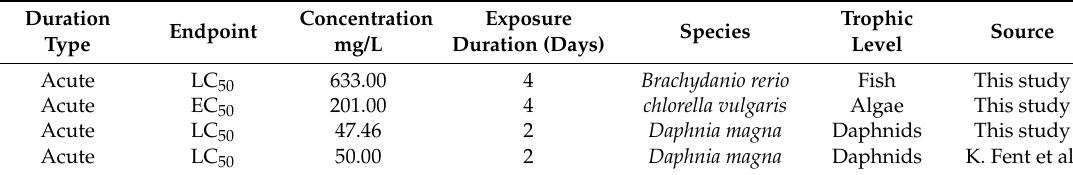
Table 5. Toxicity result of BP-4 (including the former data registered in